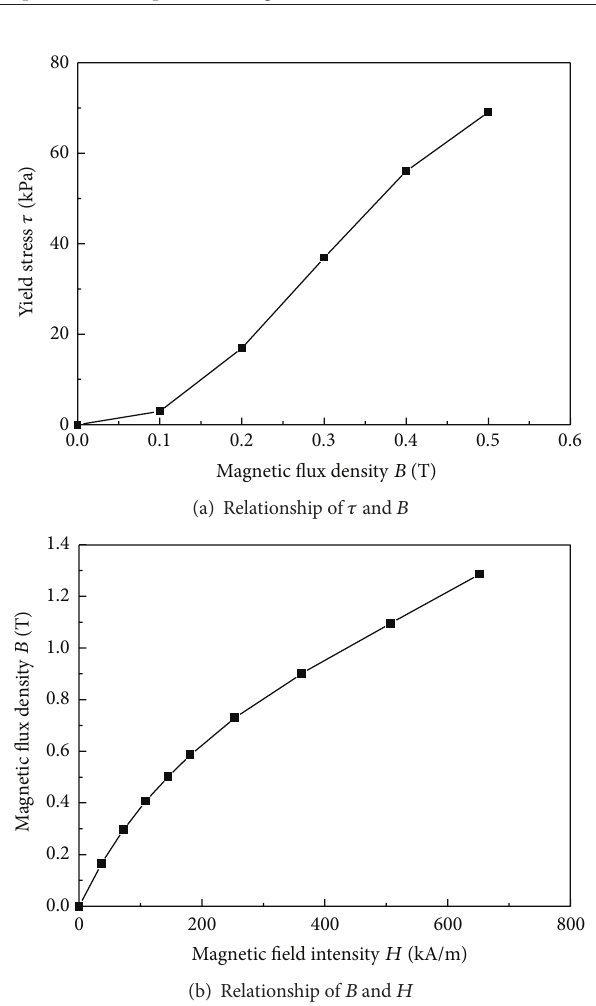
Figure 3: Specification of the MR fluid type MRF-J01T.